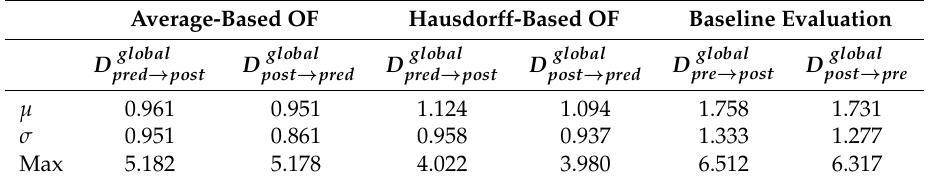
Table 8. Numerical evaluation: Global distance (in mm) between predicted PCLs and post-surgery models using RF with adaptive weights. The training set is sampled with rate of 65% and 75% due to average and Hausdorff OFs, respectively.